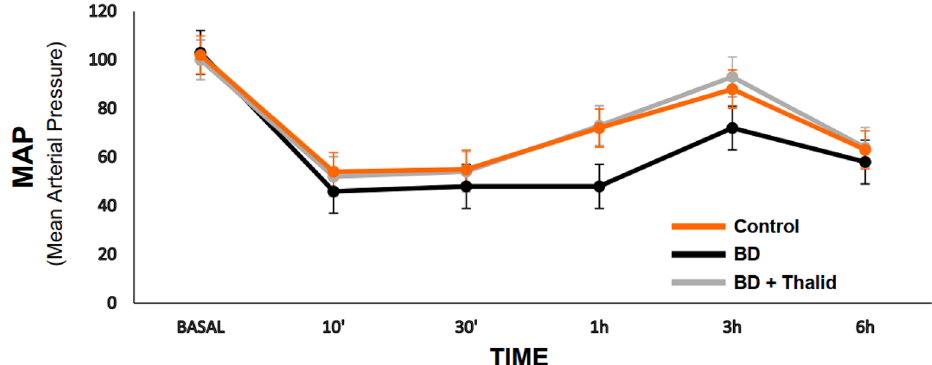
Figure 2. Mean arterial pressure analysis 6 h after brain death induction in the different groups.